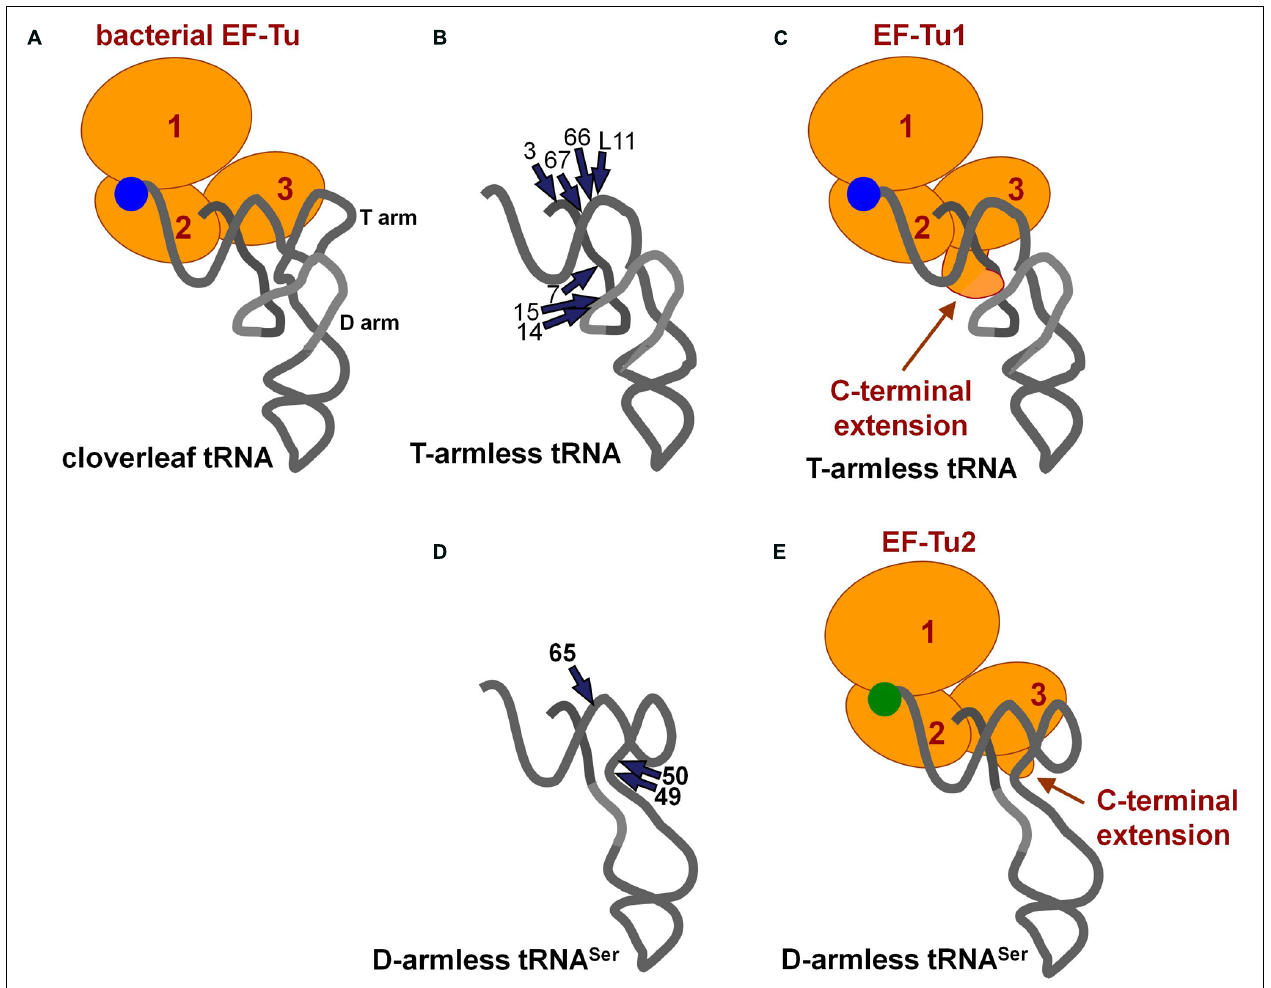
2001; Sakurai etal., 2006). (D) Summary of ENU modification interference study of D-arm-lacking mt tRNA with C. elegans mt EF-Tu2 (Suematsu etal., 2005). The tRNA structure was inferred from the model proposed by Steinberg and his co-workers (Steinberg etal., 1994). The phosphate groups important for EF-Tu2 binding are shown by arrows. (E) A model of the ternary complex of D-arm-lacking mt tRNA Ser / C. elegans mt EF-Tu2/GTP (Suematsu etal., 2005). A possible interaction between the C-terminal extension of EF-Tu2 and acceptor-T helix in D-arm-lacking tRNA is suggested by modification interference study as summarized in (D) , binding assays of mutant tRNAs, and the binding activity of EF-Tu mutants with C-terminal deletions (Suematsu etal.,